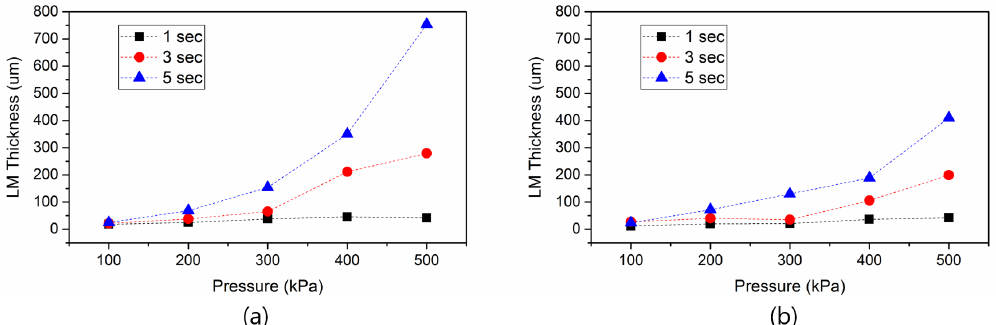
Figure 2. Characterization of sprayed LM thickness under various spraying pressures: LM thickness